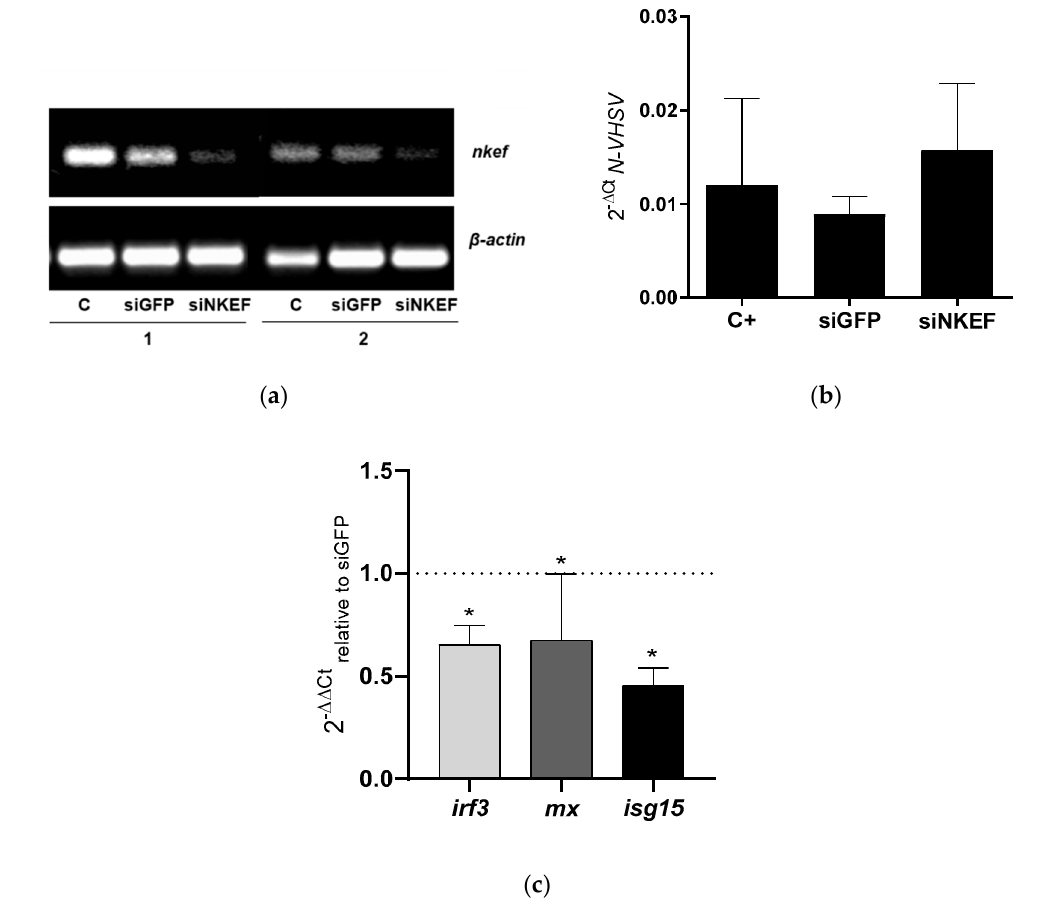
Figure 2. The effect of NKEF gene silencing on VHSV replication in RBCs. ( a ) RBCs were electroporated with siNKEF sequences. nkef gene expression was evaluated by RT ‐ PCR after 24 h. siGFP was used as a negative control, and β‐ actin was used as endogenous control gene. C indicates control, and 1 and 2 indicate the sample number. ( b ) RBCs were transfected with siNKEF and after 24 h they were exposed to VHSV MOI 1 for 24 h at 14 °C. VHSV replication was evaluated by N ‐ VHSV gene expression by RT ‐ qPCR. Om ‐ ef1 α was used as the endogenous control gene. C+ means RBCs mock electroporated and exposed to VHSV. Data represent the mean ± SD of three individuals. The Kruskal–Wallis test and Dunn ʹ s multiple comparison post hoc test were performed. ( c ) Evaluation of IFN1 ‐ related genes modulation by RT ‐ qPCR in RBCs transfected with siNKEF and exposed to VHSV. Bars represented the expression of irf3 (light grey), mx (dark grey) and isg15 (black). Gene expression was normalized to RBCs transfected with siGFP and exposed to VHSV, dashed line. The endogenous control gene used was om ‐ ef1 α Data represent the mean ± SD of n = 4 individuals. The Mann–Whitney test was performed for statistical analysis between siGFP and siNKEF transfected RBCs and exposed to VHSV. * indicates p ‐ value < 0.05.